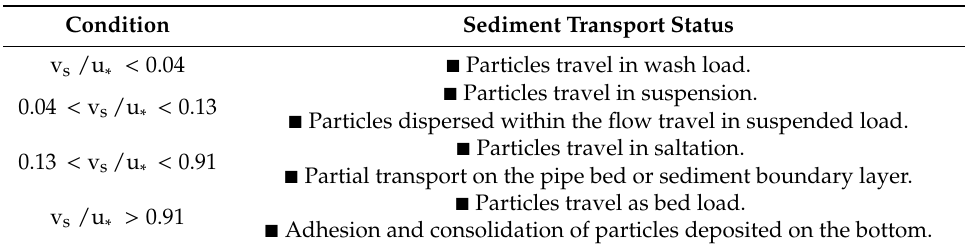
Table 6. Classification of turbulent boundary layer (this